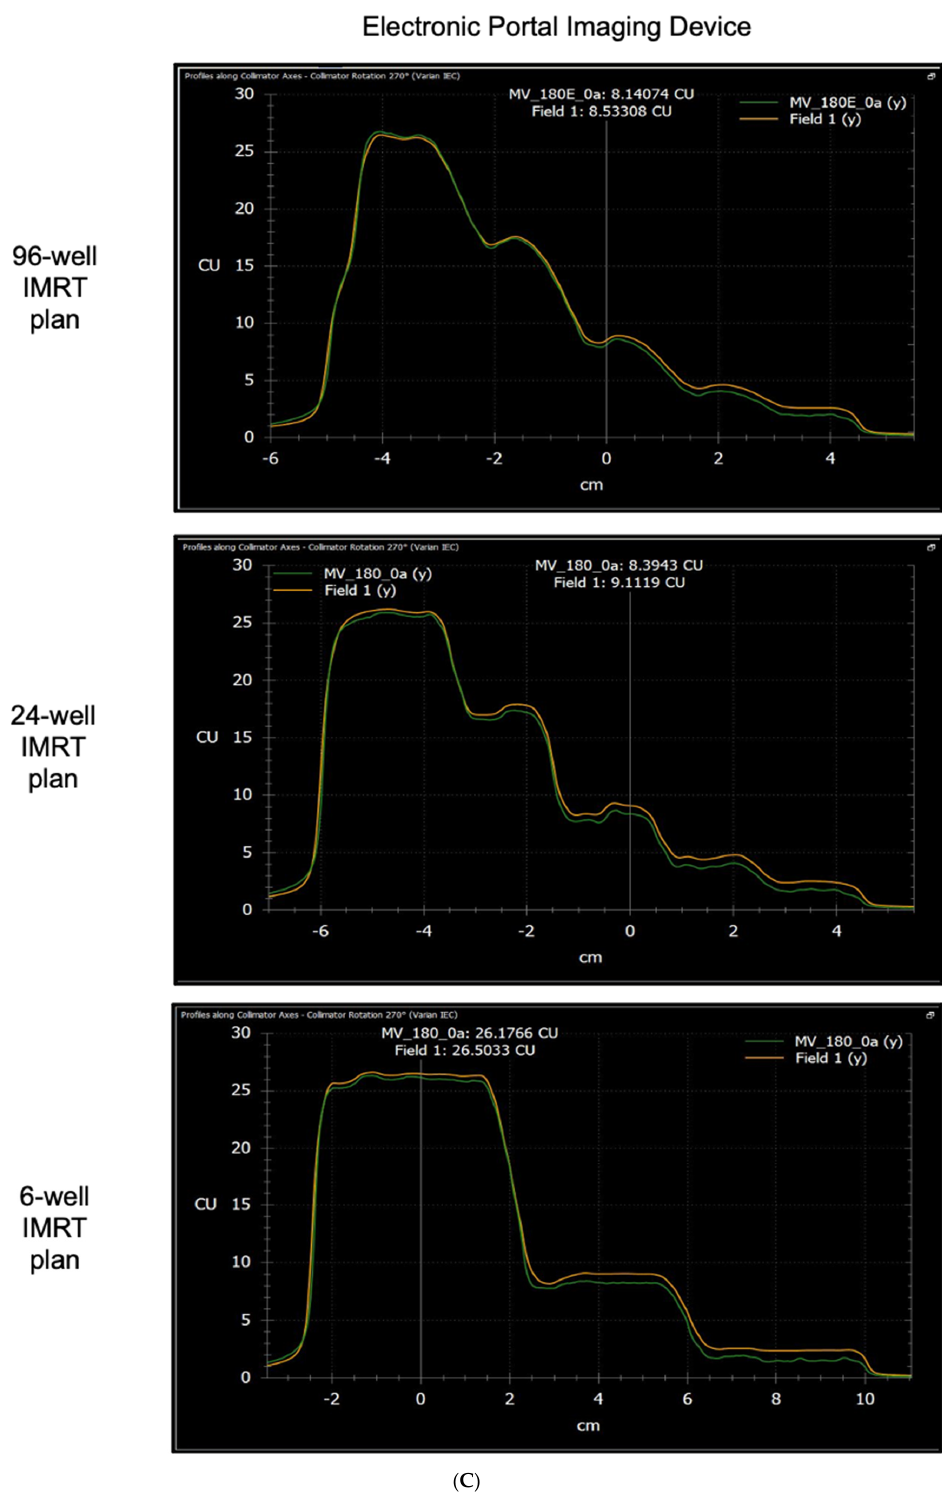
Figure 3. Dose distribution analyses of multiwell tissue culture plate IMRT plans. Screen shot images of radiochromic film ( A ); red line shows planned and green line shows predicted radiation doses across the X-axis), 2D ion chamber array ( B ); planned doses shown by orange line and measured doses by points), and EPID analyses ( C ); orange line shows predicted doses from the plan and green line shows measured